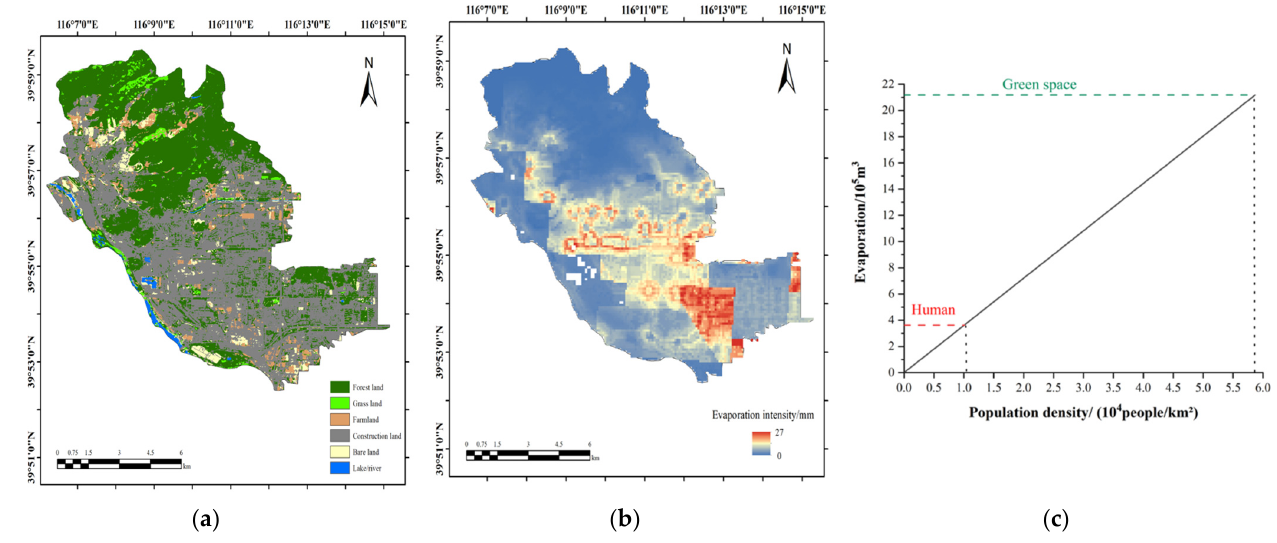
Figure 7. Land use types and evaporation from human body in Shijingshan District. ( a ) Land use types; ( b ) evaporation distribution map; ( c ) comparison between human and green space.